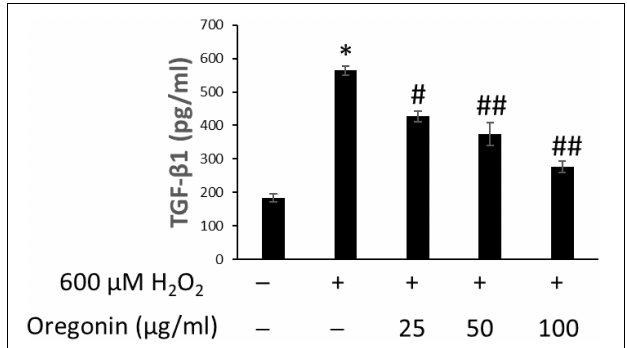
FIGURE 9 | Inhibitory effect of oregonin on TGF- β formation. The cells were pre-incubated with the indicated dose of oregonin and treated with H 2 O 2 . The TGF- β content (pg/ml) in the cell lysates was measured as described in the manufacturer’s instruction. Data were expressed as mean ± SD. * P < 0.001 vs normal group. # P < 0.05 and ## P < 0.01 vs H 2 O 2 -treated group. +, present; –, absent.